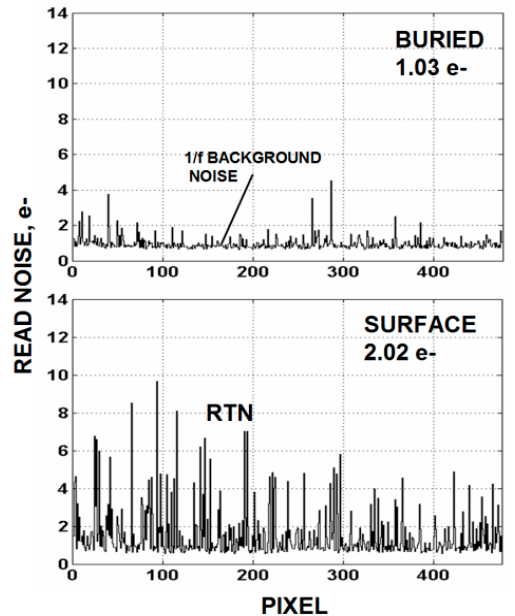
Figure 10. Buried ( top ) and surface ( bottom ) channel SF data showing more clearly that 1/ f background noise is unaffected by buried channel use.